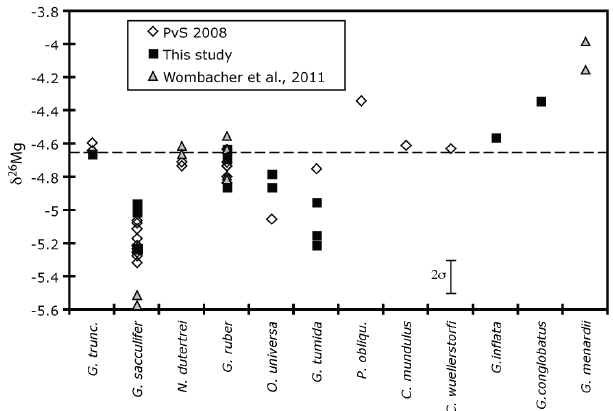
Figure 3. A compilation of Mg isotope data (Pogge von Strand- mann, 2008; Wombacher et al., 2011) from low-Mg planktonic foraminifera. Data from Chang et al. (2004) are not included, due to the lack of a data table in that publication. The dotted line represents the average of the data.